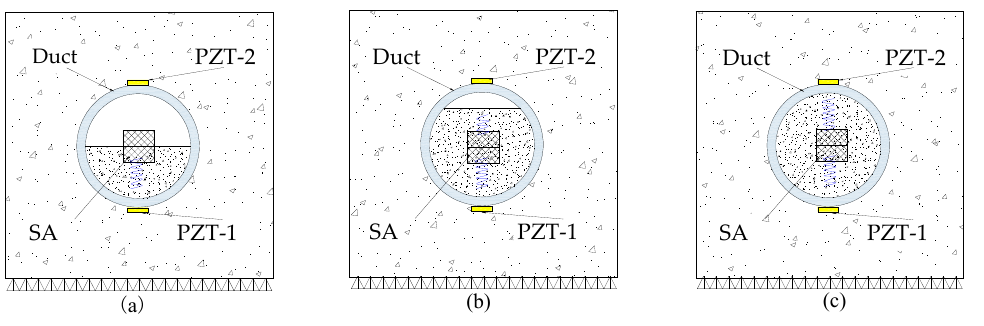
Figure 2. Three different grouting levels in tendon duct: ( a ) 50% grouting; ( b ) 90% grouting; ( c ) 100% grouting.